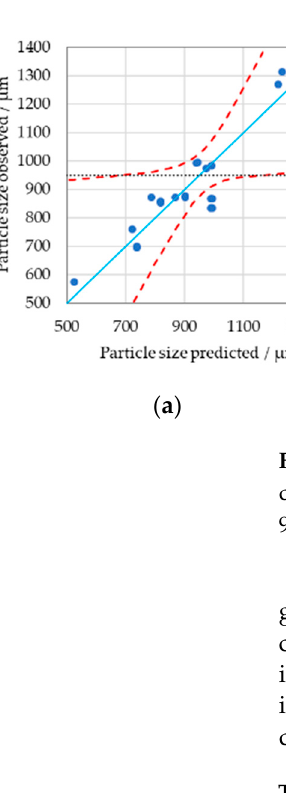
( f ) Figure 3. Crystallization results of three experiments in the DoE ( a – c ). In ( d – f ), the corresponding particle size densities are given. Here, the blue line is the q0 distribution, and the red is the q3 dis ‐